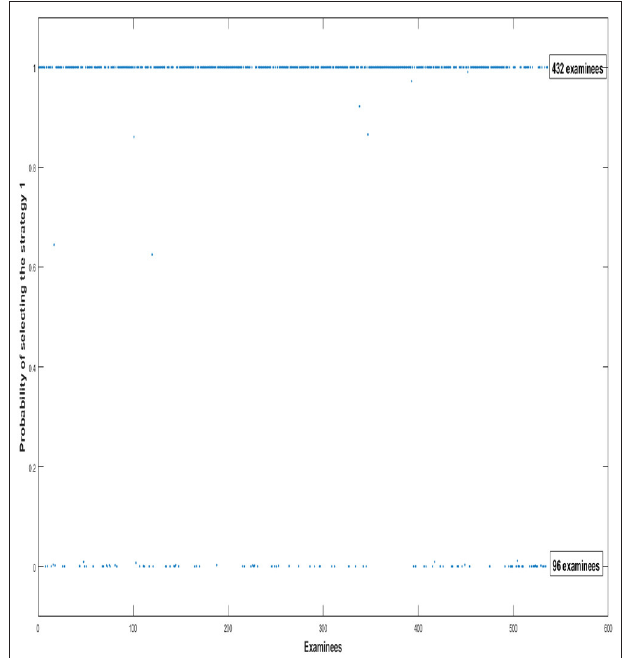
FIGURE 1 | The probabilities of examinees choosing different strategies. The y-axis indicates the probabilities of all examinees using the first strategy to answer items. 0 indicates that examinees use the first strategy to answer item with 0% probability, while 1 indicates that examinees use the first strategy to answer items with 100%